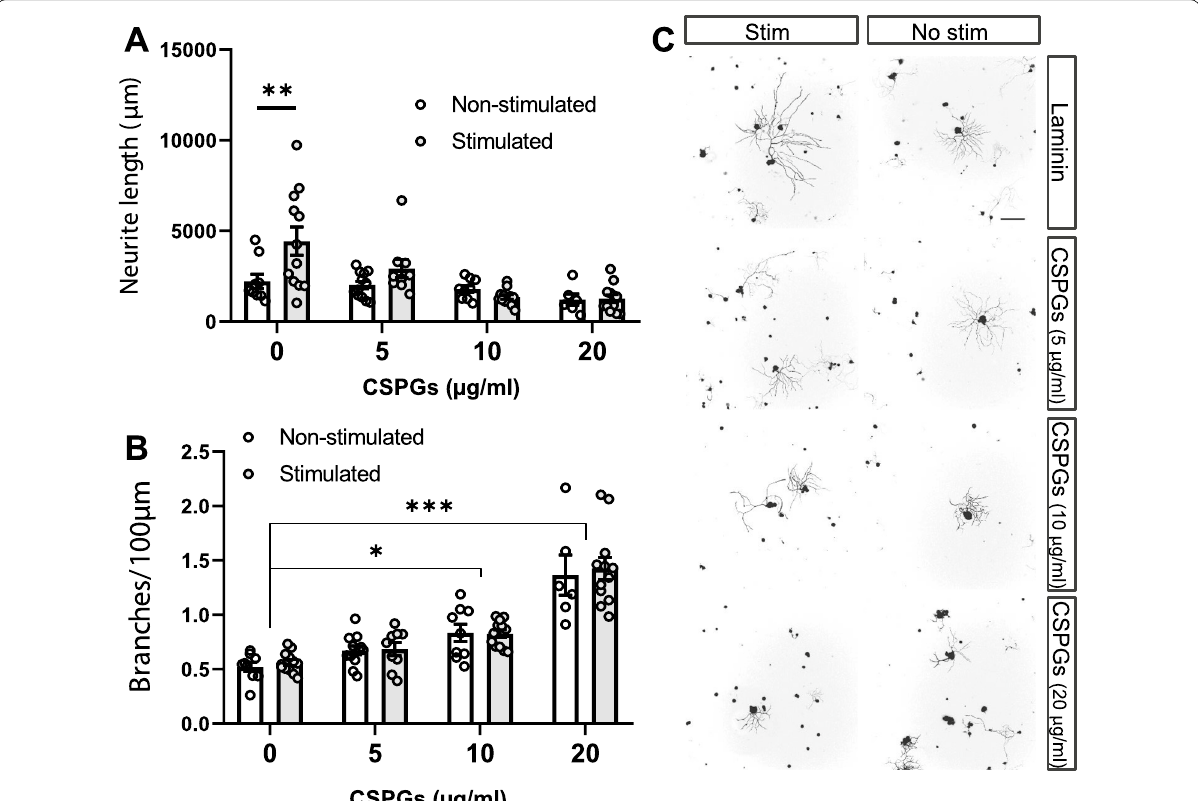
Fig. 3 Neuronal activity induces growth on permissive but not inhibitory substrates. A Neurite outgrowth was significantly increased in optogeneticallty stimulated DRG neurons over growth‑permissive substrates (0; laminin), but not over different concentrations (5, 10, 20 μg/ml) of non‑permissive substrates (CSPGs). Average neurite length per neuron was determined at 24 h in vitro. Data are expressed as mean neurite length per cell s.e.m (n 7–12 images). **p < 0.01 denotes significant differences in ANOVA followed by Bonferroni test. B Neurite branching is increased ± = dose‑dependently by CSPGs but is not affected by neuronal stimulation. Average number of branches for each 100 µm was determined at 24 h in vitro. Data are expressed as mean s.e.m (n 7–12 images; *p < 0.05; ***p < 0.005 denote significant differences vs respective 0 µg/ml condition ± = in ANOVA followed by Bonferroni test). C Representative images of Tuj‑1 staining used to analyze neurite length. Scale bar: 200